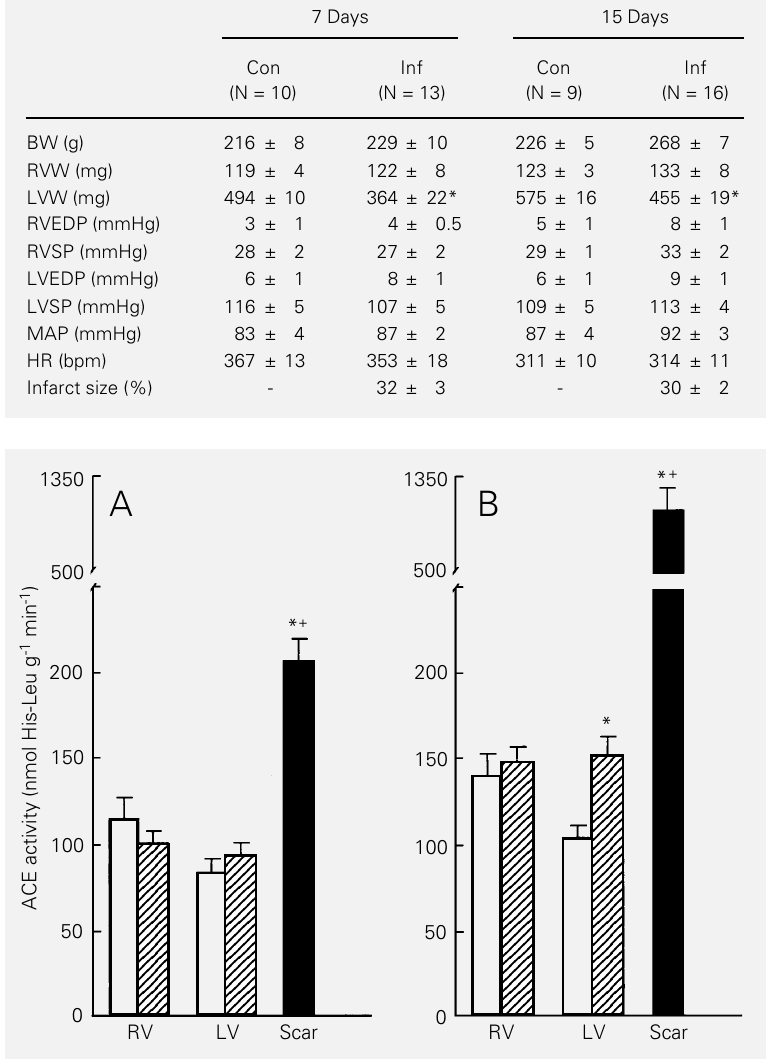
Figure 1 - Angiotensin-converting enzyme (ACE) activity in the right ventricular free wall (RV) and in the left ventricle muscle (LV) of sham-operated control (open bars) and infarcted rats studied 7 (panel A) or 15 (panel B) days after coronary artery occlusion or sham surgery. In the infarcted groups, ACE activity was assayed separately in the surviving left ventricular muscle (hatched bars) and in the scar tissue (closed bars). Observe the great increase in ACE activity in the scar tissue 15 days after infarction. Data are reported as means – SEM. N is the same as in Table 1. *P<0.05 vs control group; + P<0.001 vs surviving left ventricular